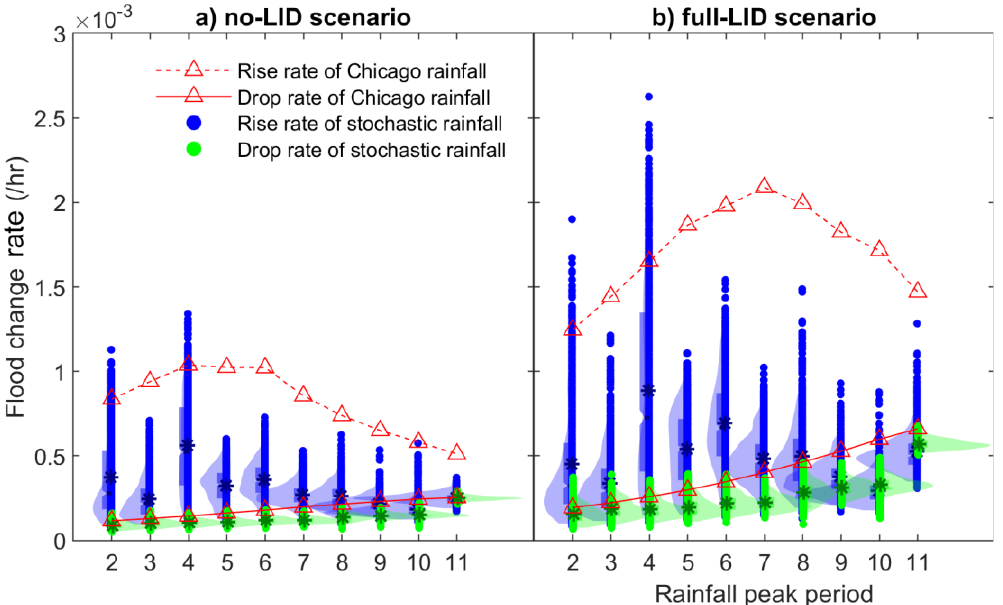
Figure 8. Rise and drop rates of flood time series in ( a ) no- and ( b ) full-LID scenarios under Chicago and stochastic precipitation events. * represents the median.